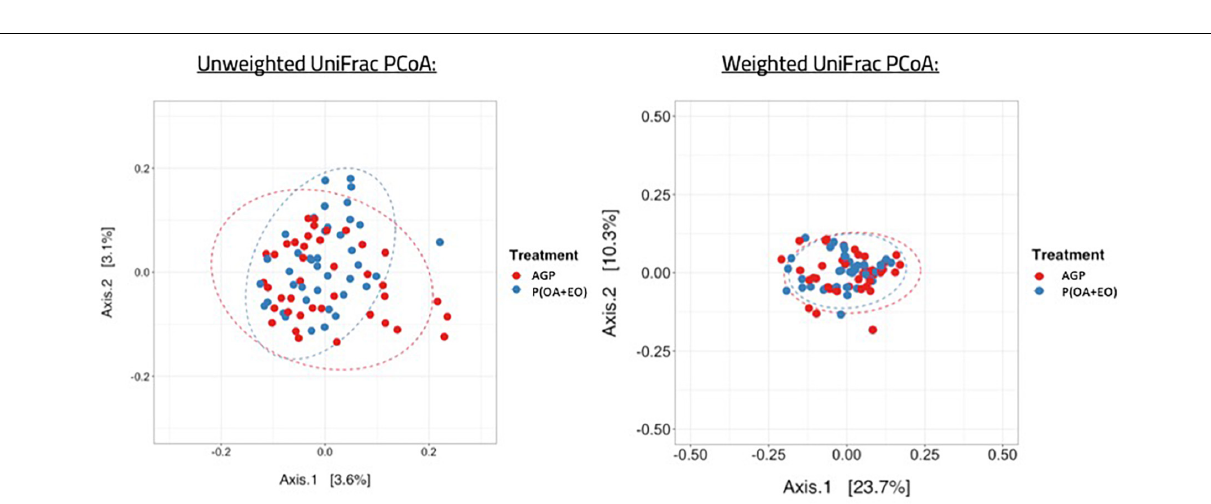
FIGURE 3 | Beta diversity of the cecal microbiota of broiler chickens supplemented with antibiotic growth promoter (AGP) or protected organic acids (OA) and essential oils (EO) [P(OA + EO)] raised under field conditions. Values are means of 40 replicates (Unweighted UniFrac: P = 0.019; Weighted UniFrac: P > 0.05).